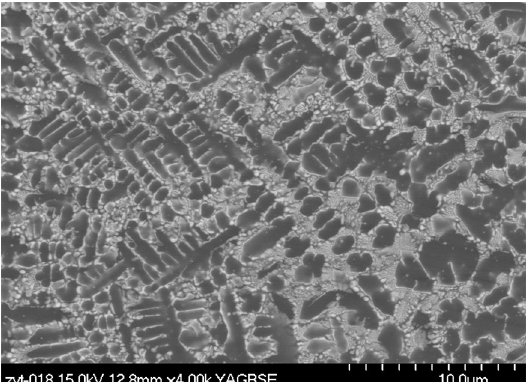
Figure 8. Back scattering electron image of the dendrite crystal.